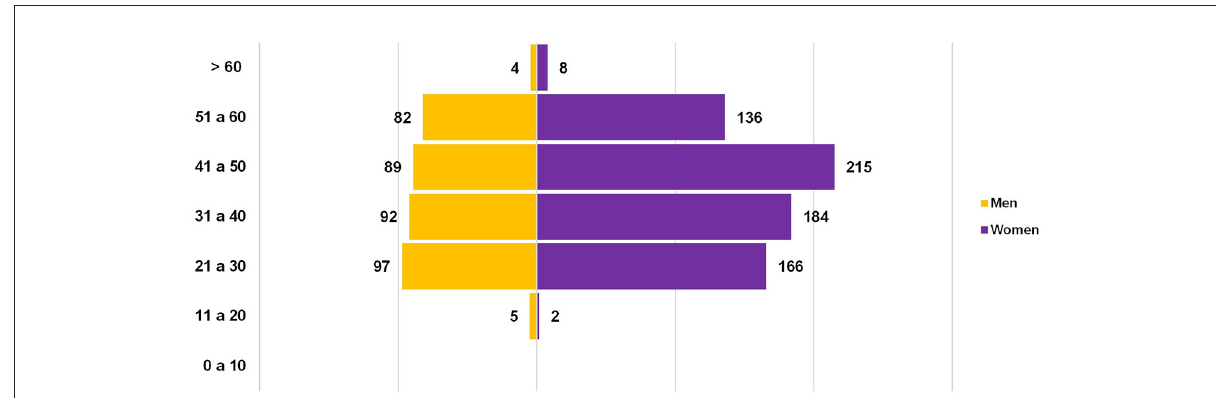
FIGURE2 Distribution of INER staff by age and